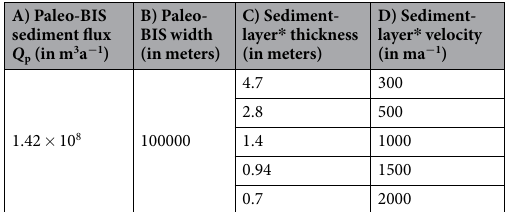
Table 2. (A) Paleo Bindschadler Ice Stream sediment flux; (B) Paleo Bindschadler Ice Stream width. (C–D) Possible pairs of effective sediment layer thickness (from both deforming basal till and sediment-rich basal ice layer) and sediment-layer velocity, respectively. * The sediment layer includes the deformation till and cumulative sediment within basal-ice layers. BIS = Bindschadler Ice